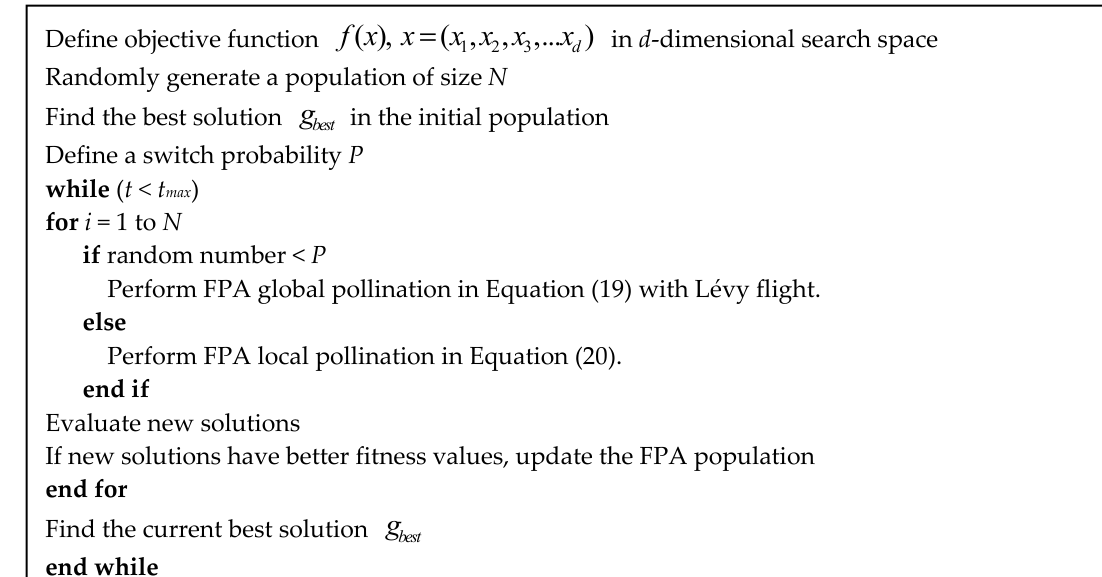
Figure 2. Pseudo code of the flower pollination algorithm (FPA) [7–9].